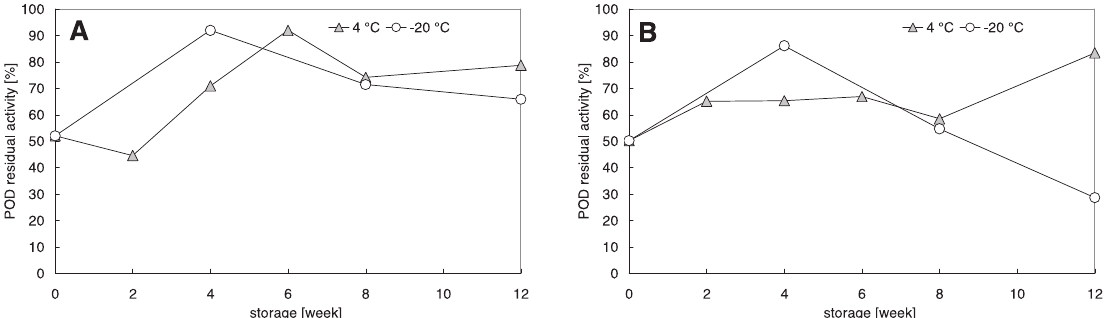
Fig. 4: Residual POD activities during 12 weeks of storage of celeriac pastes, processed at 90 °C (A) and 95 °C (B). Residual POD activities based on the initial POD activity in unheated